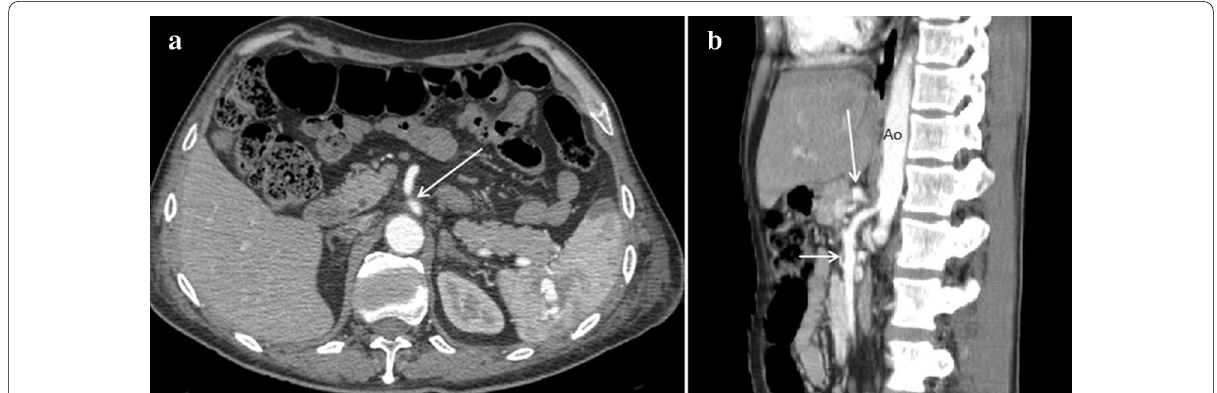
Fig. 17 Abdomen MRI examination. a The axial plane reconstruction shows a stenosis of CA (long arrow); origin off the abdominal aorta (short arrow). b The axial plane reconstruction, cranially to the CA origin, shows the MAL (arrows). Abdominal aorta (short arrow)